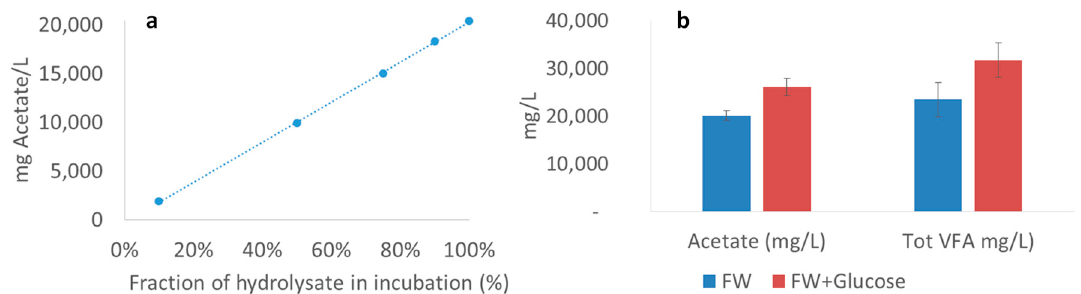
Figure 4. ( a ) Correlation between fraction of hydrolysate after two days of inoculation and absolute acetate concentration (R 2 = 0.9997). ( b ) Concentration of acetate and total volatile fatty acids (VFA) with only food waste (FW) (blue) compared with FW plus extra dissolved organic carbon (red).